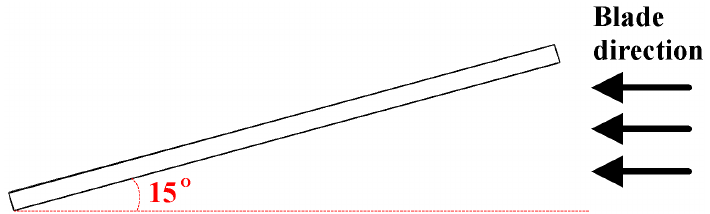
Figure 2. Top-down illustration of the orientation of the powder bed fusion (PBF) sheet during manufacture; thickness: 1 mm, length: 30 mm.